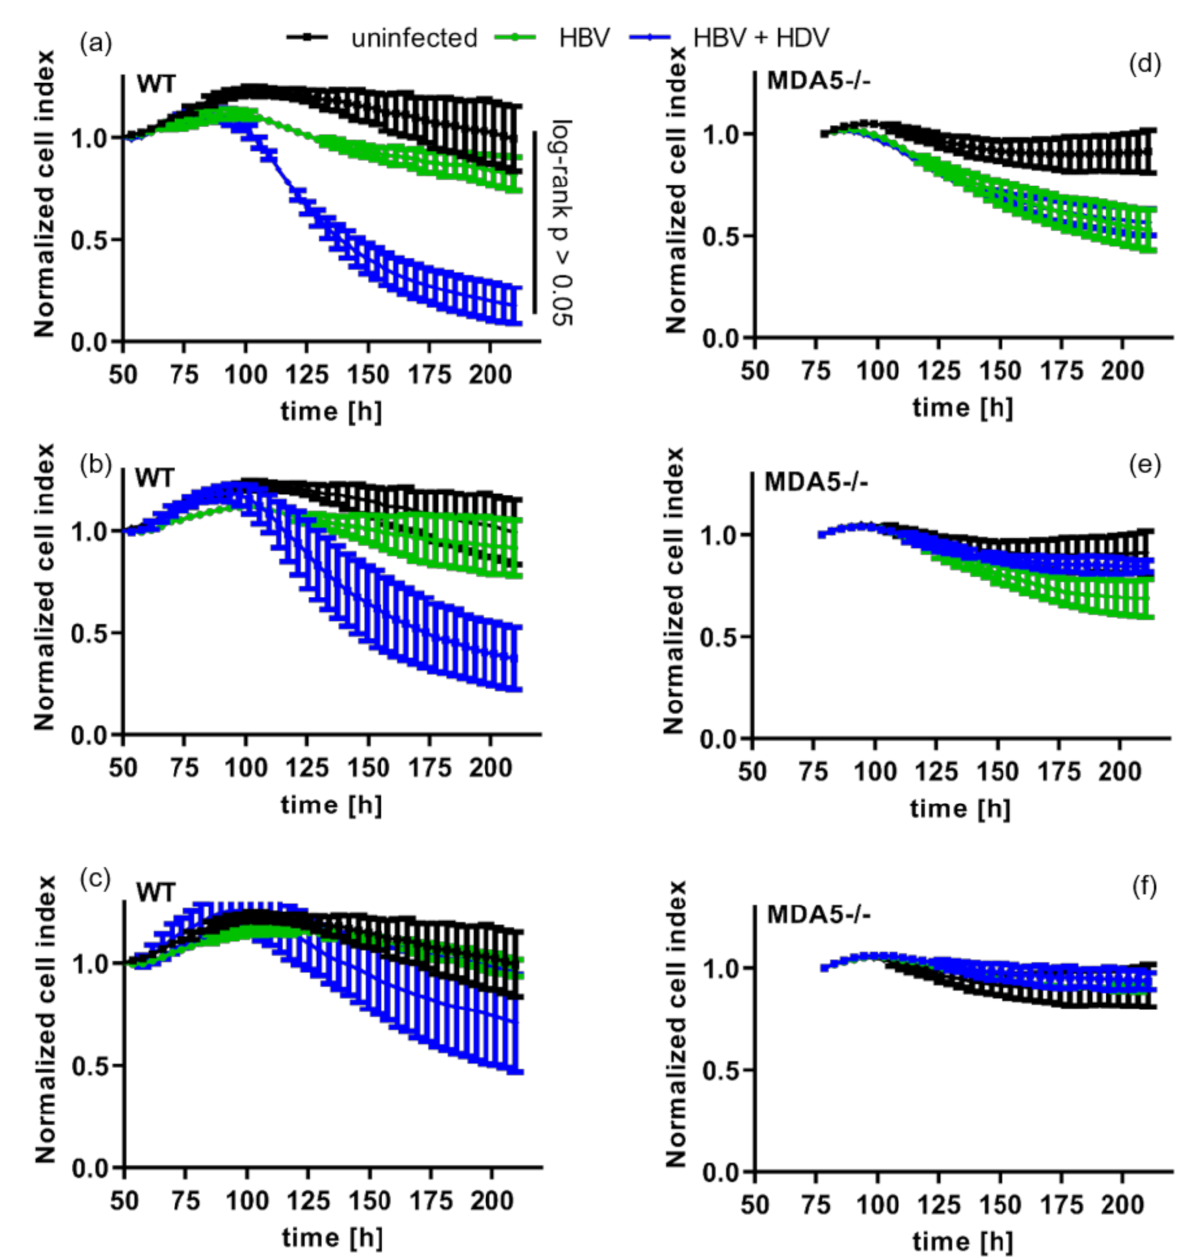
Figure 6. S-CAR T-cell dependent cytotoxicity independent of antigen presentation is increased by HDV recognition via MDA5. Maternal and MDA5-/- HepG2-NTCP cells were infected with HBV at an MOI of 100 vp/cell and, if indicated (blue lines), coinfected with HDV at an MOI of 40 vp/cell. Cells were co-cultivated with S-CAR transduced T-cells at 9 dpi at an effector to target cell ratio of 1:1 ( a , d ), 1:3 ( b , e ) and 1:9 ( c , f ) and subjected to real-time cell viability assay. Graphs depict T-cell induced elimination of HBV infected cells reflected by a decreasing normalized cell index. Co-Culture starts at 48 h. Graph represents a single experiment per line with biological triplicates. Statistical analysis of survival curves was done using Kaplan–Meier tests and log-rank